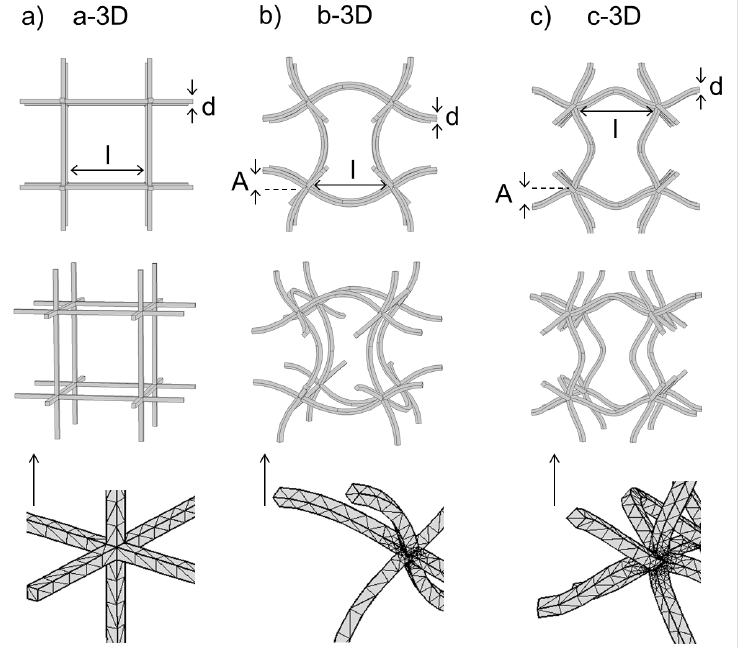
Figure 3. Three-dimensional unit cells: Upper row: xy-direction, middle row: scenography, lower row: mesh: ( a ) Quadratic unit cell; ( b ) Eigenmode with chiral nodes; ( c ) Eigenmode with fixed